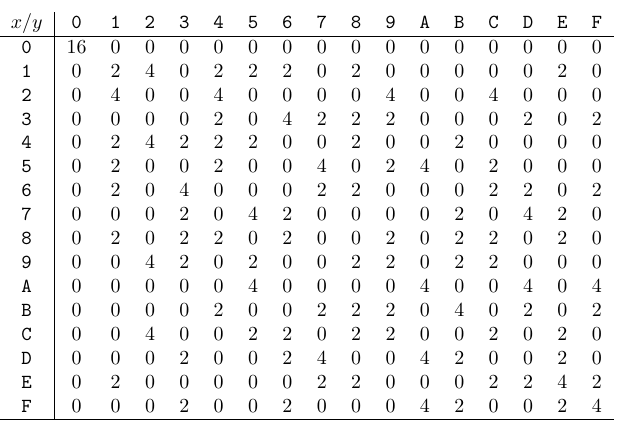
Table 6: Differential distribution table (DDT) of CRAFT